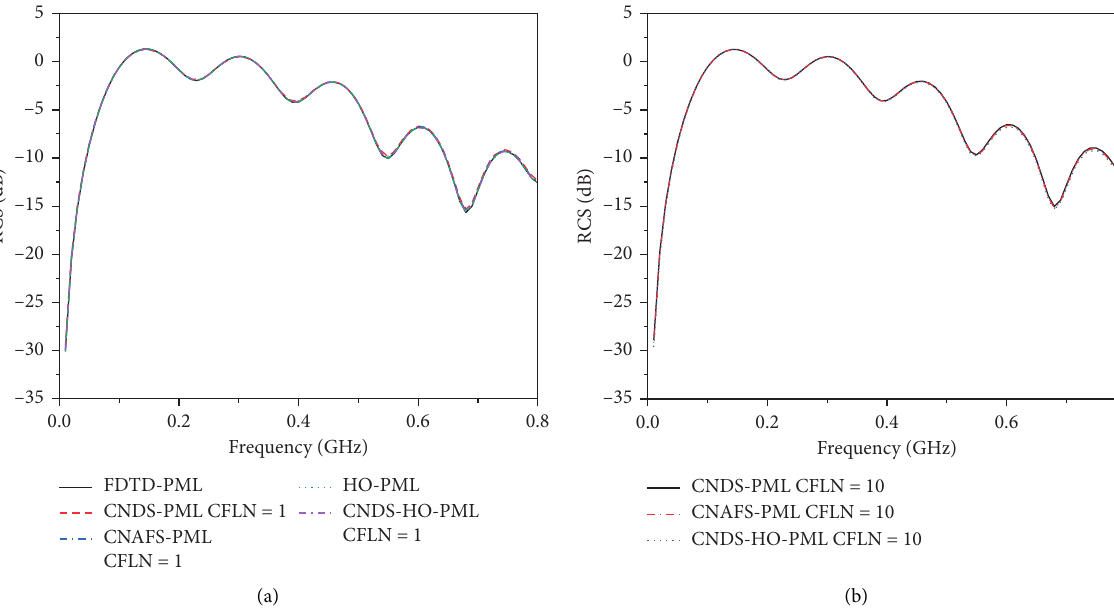
Figure 4: The RCS of the flight vehicle model versus frequency with plasma sheath obtained by (a) FDTD-PML, CNDS-PML, CNAFS-PML, HO-PML, and CNDS-HO-PML CFLN � 1; (b) CNDS-PML, CNAFS-PML, and CNDS-HO-PML CFLN �